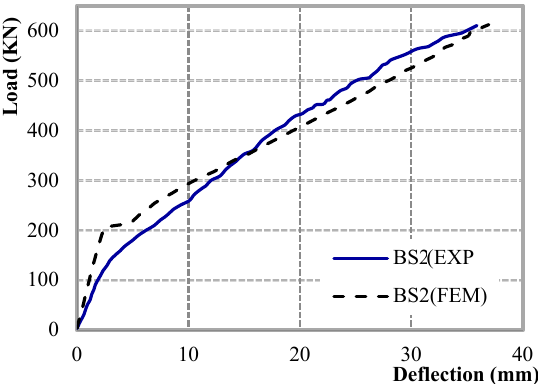
Figure 22. Load-deflection curve of BS2 slab.